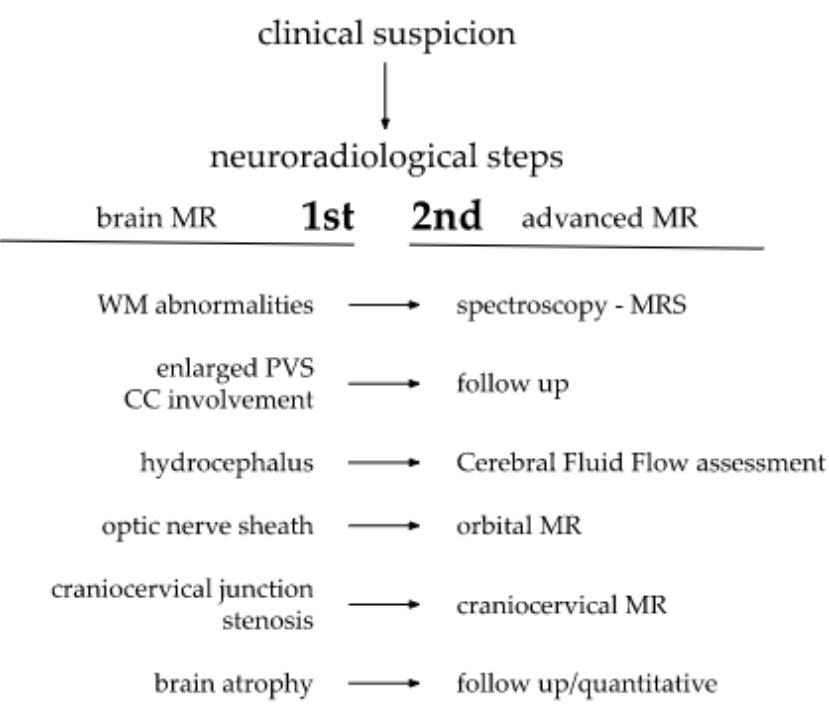
Table 3. CNS imaging